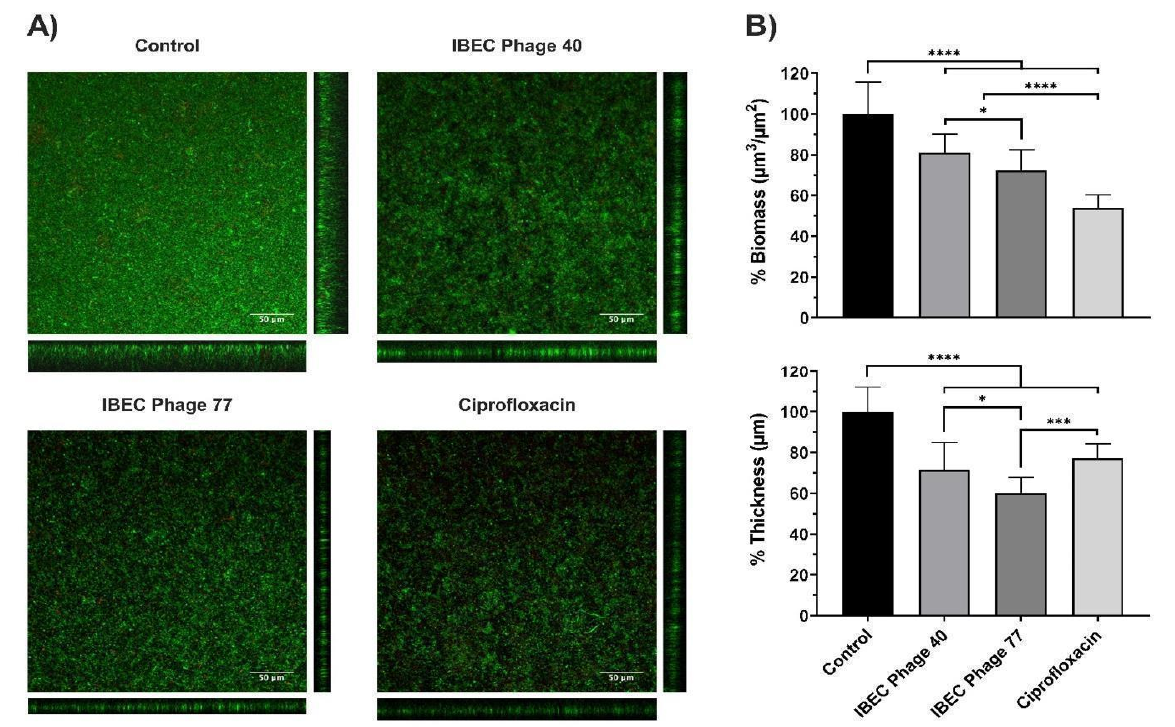
Figure 5. The relative effect of E. coli CFT073 specific IBEC77 and E. coli CFT073 non-specific IBEC 40 against 96 h biofilms formed under flow conditions. Phages at 1 × 10 7 pfu/mL, Ciprofloxacin 1 µg/mL, and LB Broth were employed as treatments. ( A ) Confocal microscopy images (sum and orthogonal views) of stained biofilms and ( B ) biomass and average thickness reduction with respect to control. Standard deviations of data from two different replicates are indicated. Statistically significant differences (* p < 0.05, *** p < 0.001, **** p < 0.0001) were determined by an ordinary one-way ANOVA (GraphPad Prism v.9).